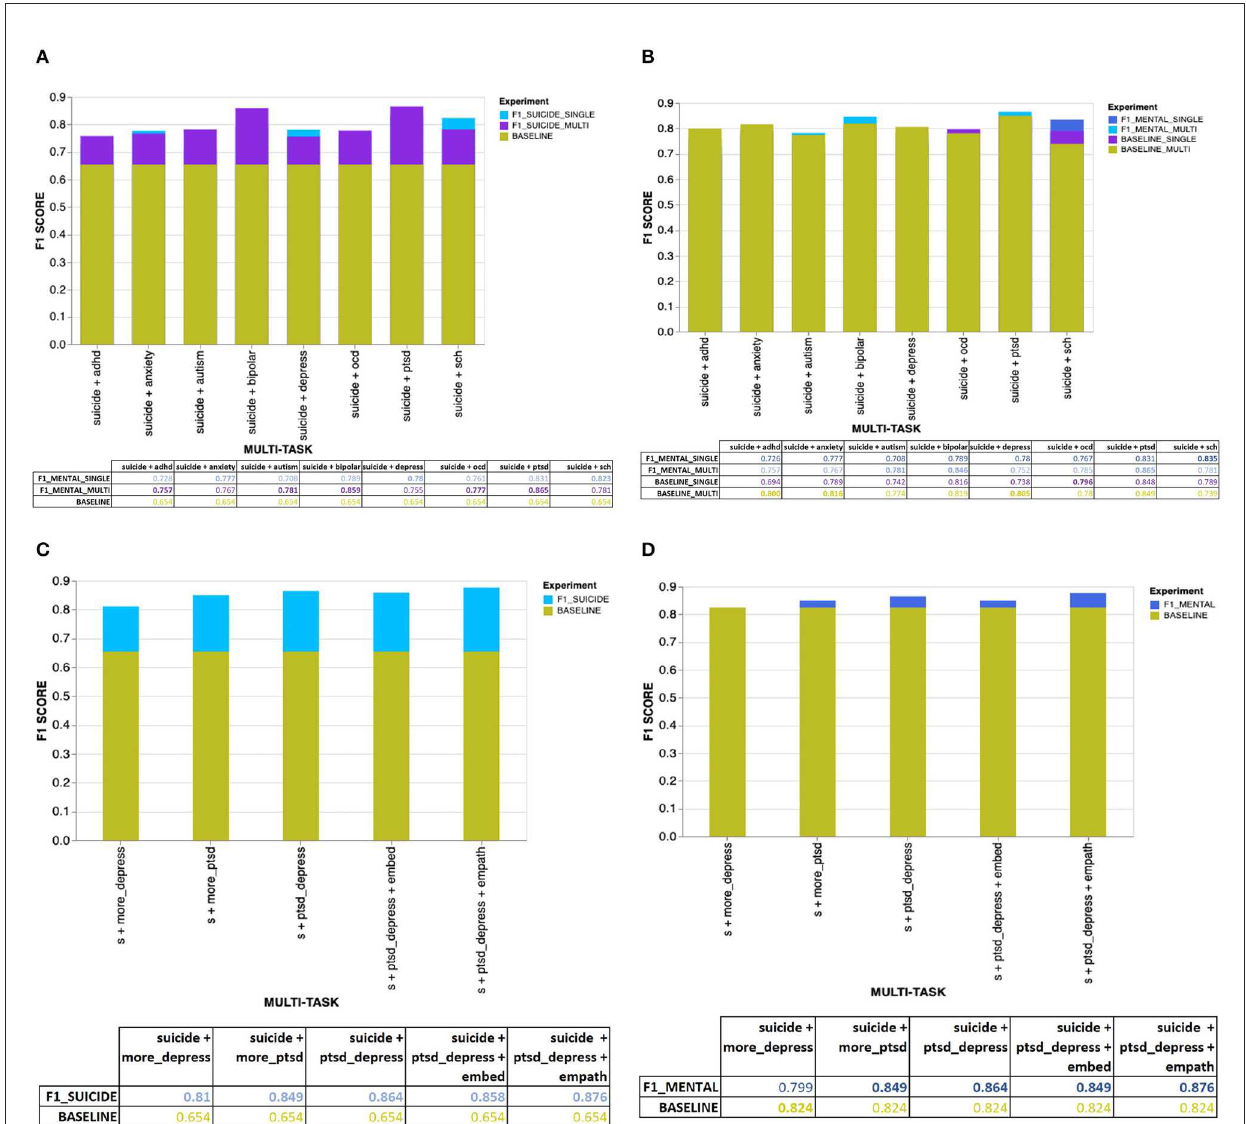
FIGURE4 (A) Overall results for the suicide ideation detection task with users diagnosed with single or multiple mental disorders. (B) Overall results for the mental illness detection task with users diagnosed with single or multiple mental disorders. (C) Overall results for the suicide ideation detection task with users diagnosed with mental disorders using CLPsych 2015 data (either PTSD or depression). (D) Overall results for the mental illness detection task with data from users diagnosed with either PTSD or depression (using the CLPsych 2015